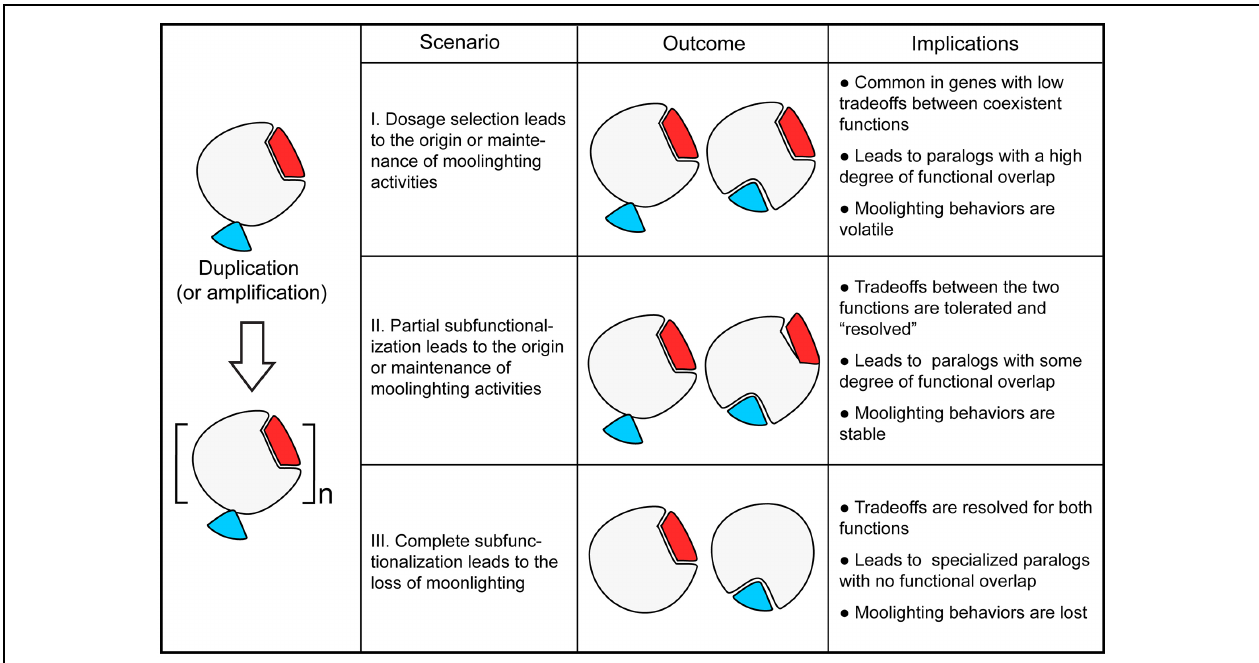
FIGURE 1 | The fate of moonlighting proteins after gene duplication. The interplay between different mechanisms of gene evolution by duplication (including amplification) influence the origin, retention, and loss of moonlighting proteins. (I) Gene duplication may enable the origin or retention of moonlighting proteins over time by selection for dosage amplification of one or more molecular functions in the ancestor (e.g., yeast Rpl2A/Rpl2B). (II) Incomplete subfunctionalization of one or more molecular activities in the ancestor may